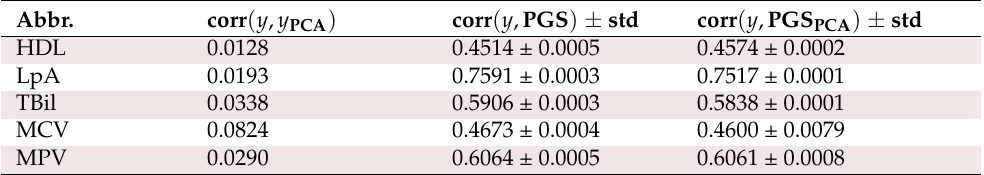
Table 2. Including Principal Component effect on the PGS predictors has negligible effect. Results are for self-reported Europeans within the sibling